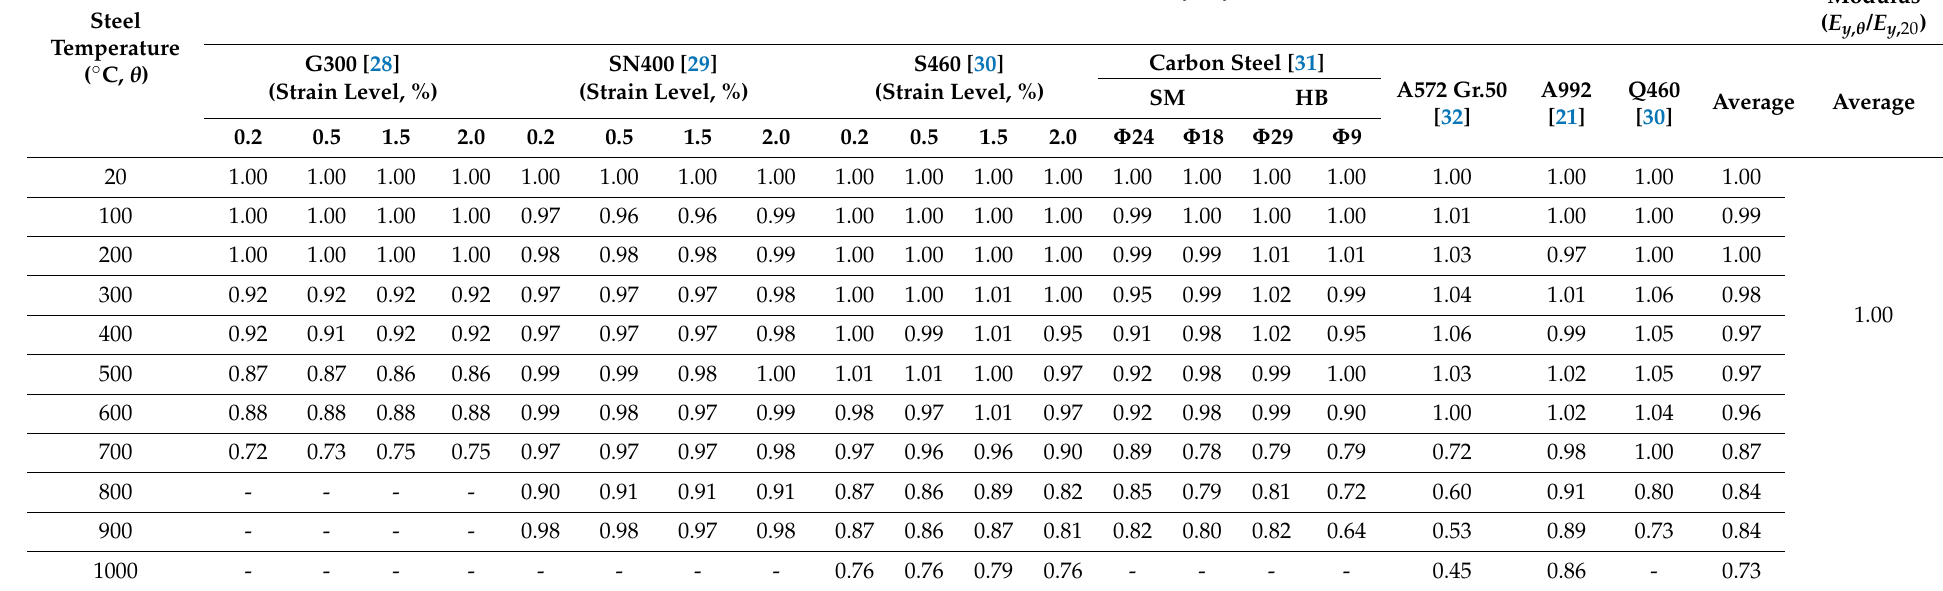
Table 2. Reduction factor of mild steel after the